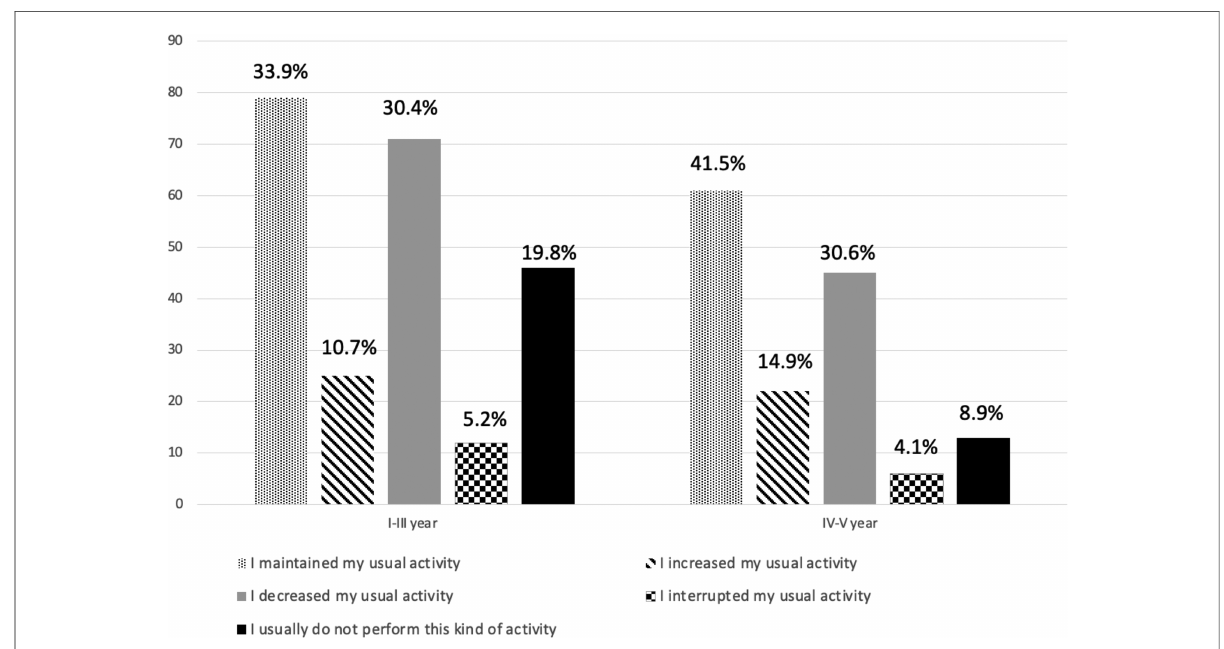
FIGURE 2 Impact of COVID-19 second wave on training and research activities according to attended year of residency.